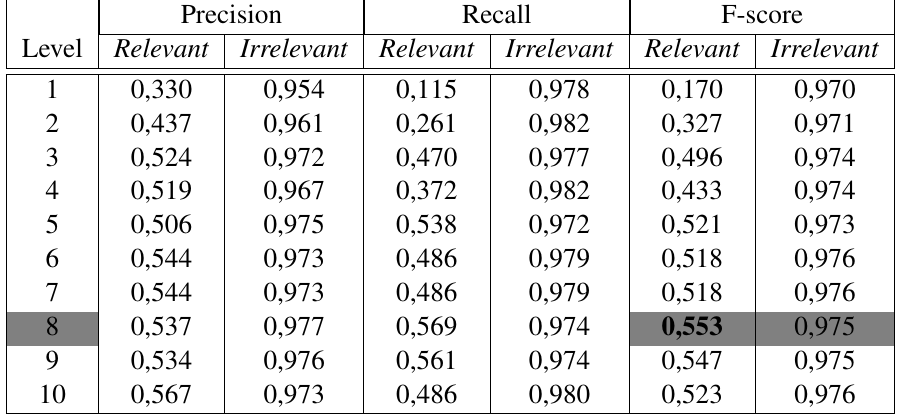
Table 2: Results achieved by the BN classifier for each MeSH level in the category A. Precision Recall